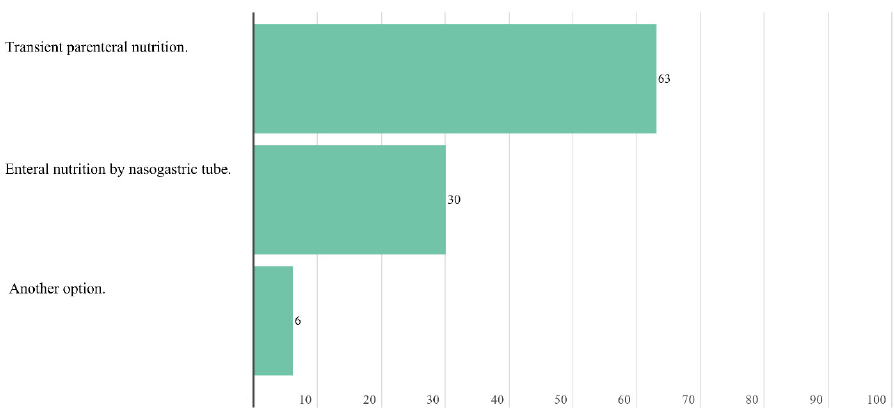
Figure 9. Answers to the question “In patients with already established grade IV oral and/or esophageal mucositis that prevents adequate swallowing, what nutritional therapeutic option would you choose?”.